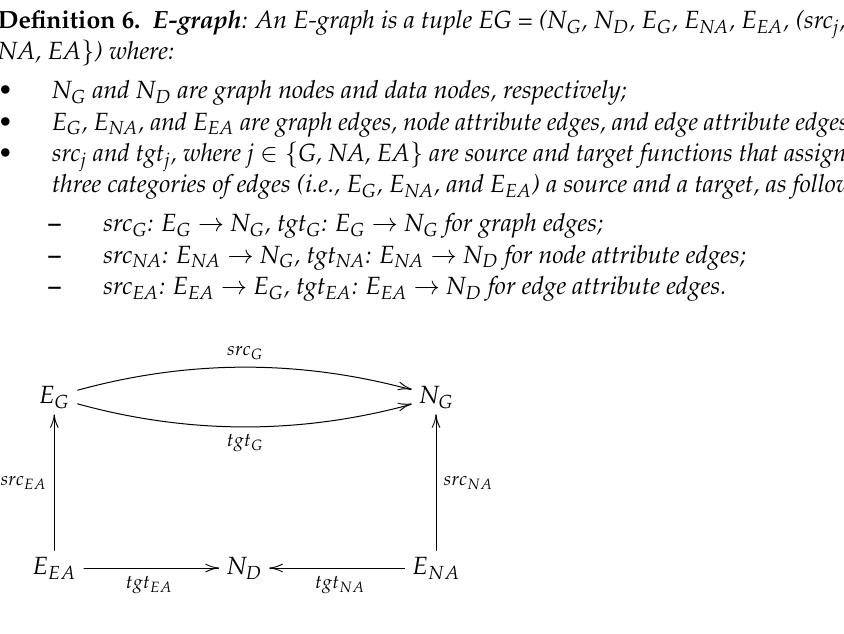
Figure 10. A visualization of an E-graph.